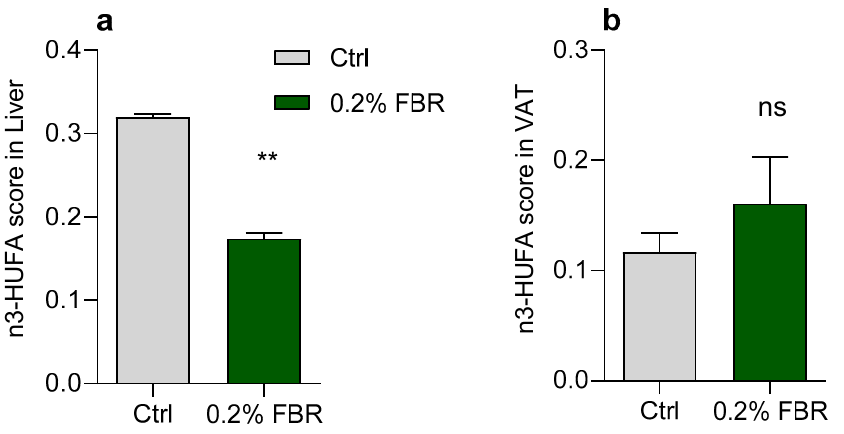
Figure 2. n3‑highly unsaturated fatty acid (HUFA) scores of mice fed a control diet (Ctrl) or a 0.2% fenofibrate‑supplemented diet (0.2% FBR) in ( a ) liver; ( b ) visceral adipose tissue (VAT). Data are expressed as mean ± SEM of n = 5. ** p ≤ 0.01; ns = not significant. Hepatic total lipids were lower in 0.2% FBR mice with respect to Ctrl, and this pattern Table 1. Main fatty acids (FA) in liver of mice fed a control diet (Ctrl) or a 0.2% fenofibrate‑ was also observed for n3- and n6-PUFA (Table 1). Arachidonic acid (20:4n6, ARA) and supplemented diet (0.2% FBR). Data are expressed as nmoles/mg of lipids and represent the mean ± SEM of n = 5. * p ≤ 0.05; ** p ≤ 0.01; ns = not